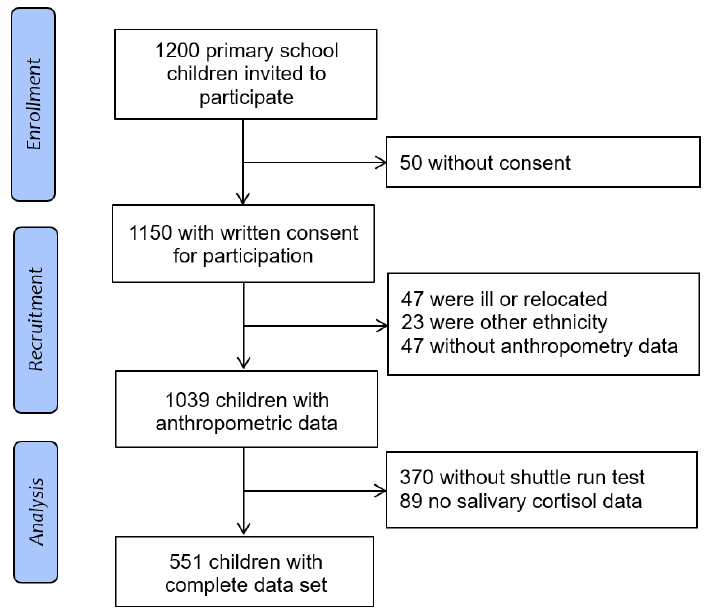
Figure 1. Flow diagram of the study population.